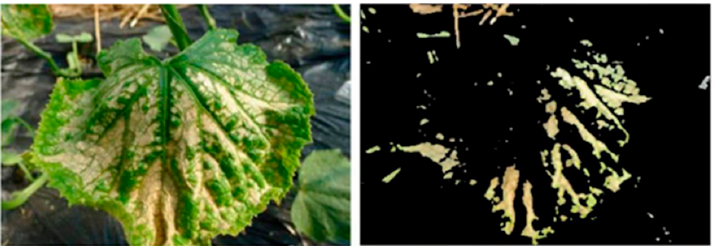
Figure 3. Input image and detection result for plant disease diagnosis with image technology. The leaf has lost its color due to disease attack [49].